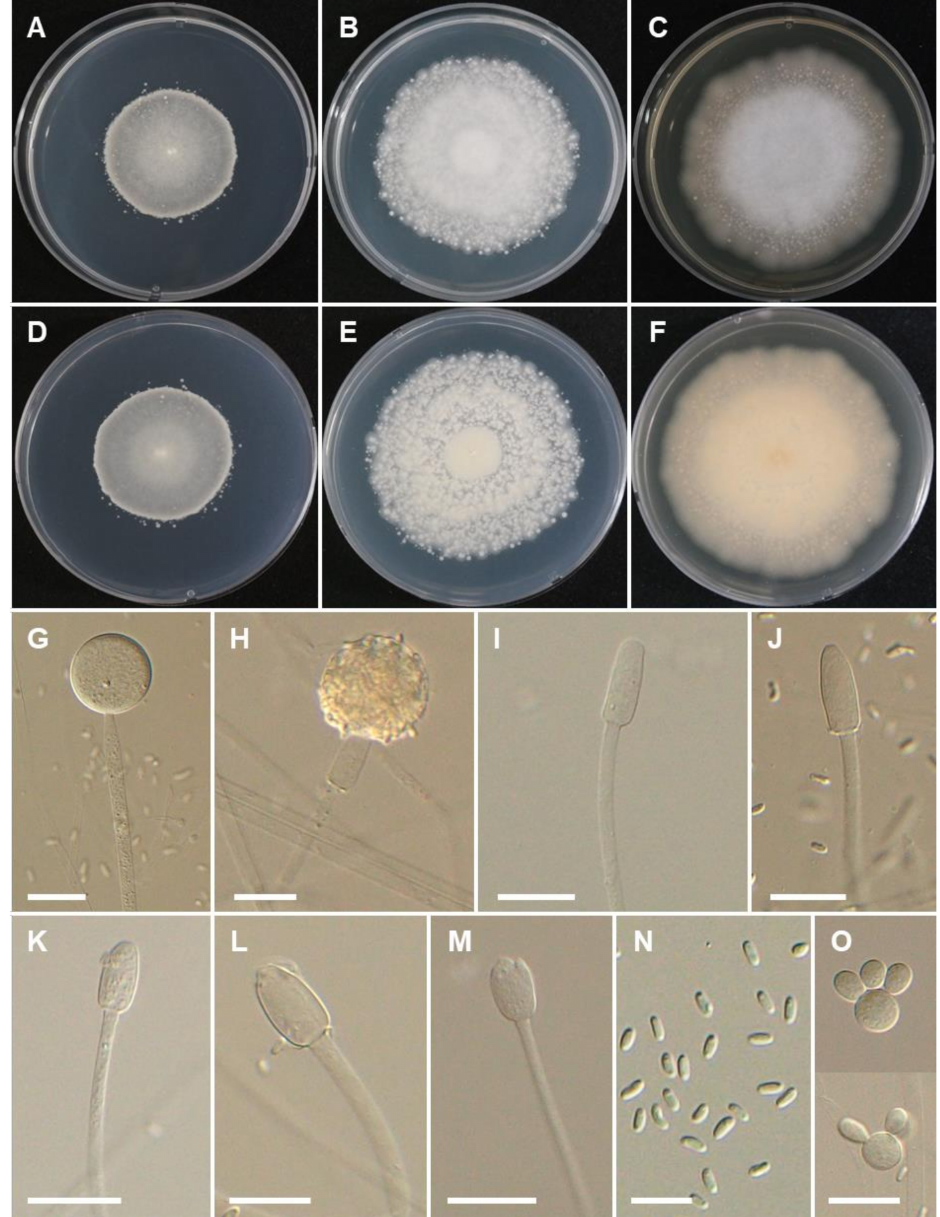
Figure 5. Morphology of Mucor kunryangriensis . ( A , D ) Colony on synthetic agar mucor (SMA). ( B , E ) Colony on potato dextrose agar (PDA). ( C , F ) Colony on malt extract agar (MEA). ( G , H ) Young and mature sporangia. ( I – M ) Typical columellae. ( N ) Sporangiospores. ( O ) Yeast-like cells. Scale bars = 20 µ